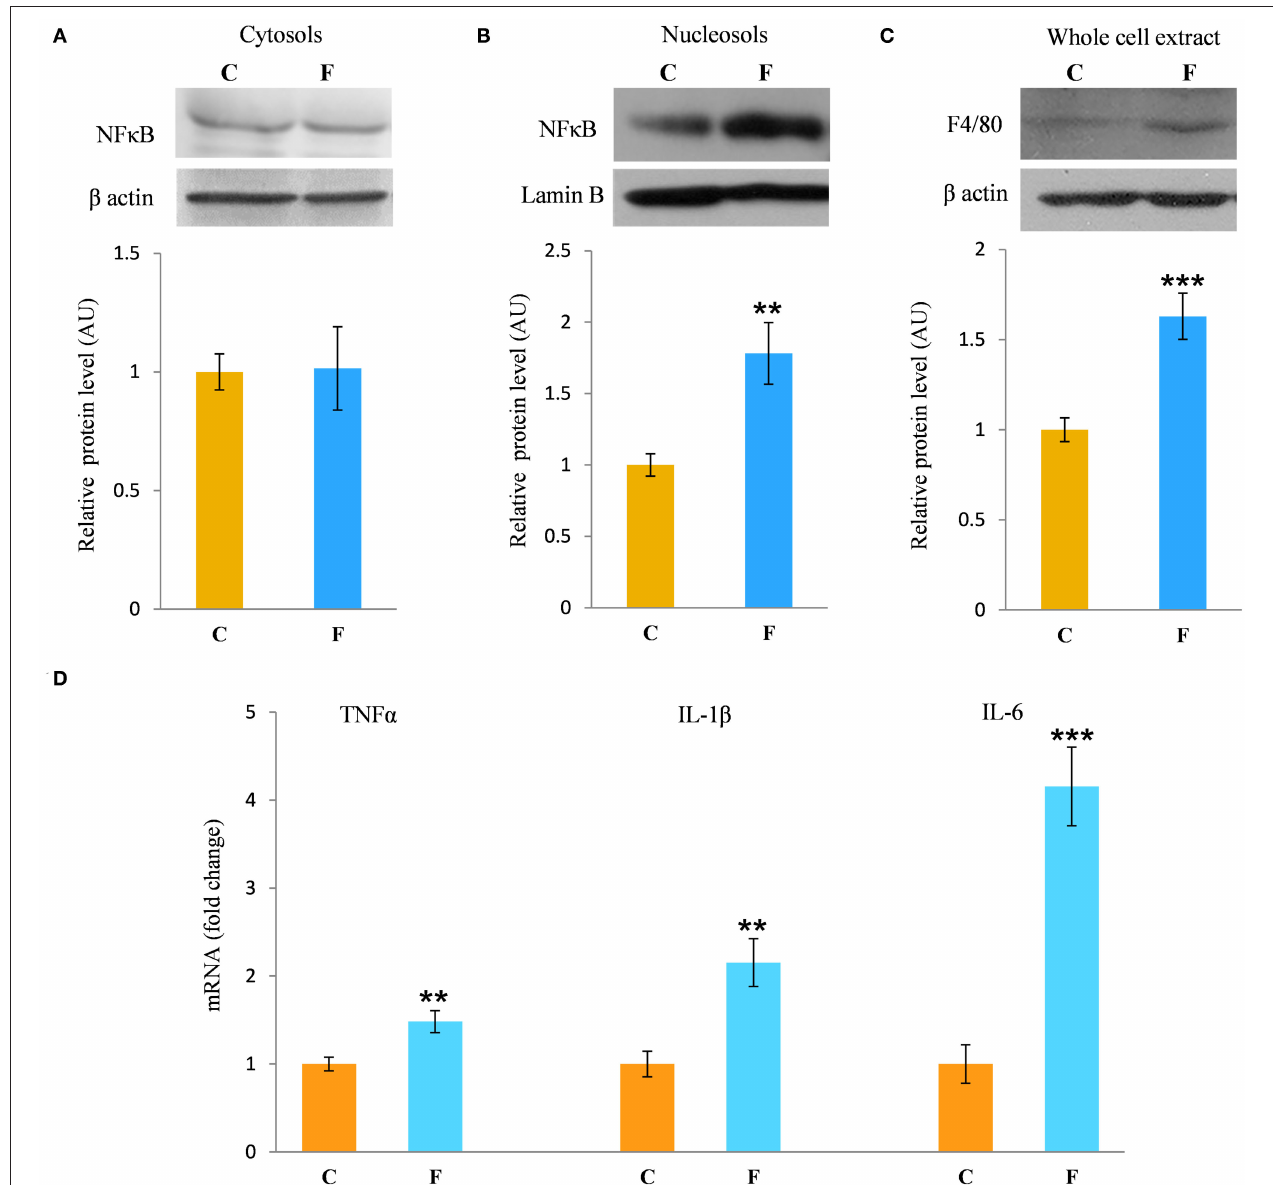
FIGURE 6 | Inflammation in the VAT of female rats fed with 10% fructose diet for 9 weeks. Protein level of NF κ B in (A) cytosols and (B) nucleosols, and protein level of (C) F4/80 in whole cell extracts were measured by Western blot in the VAT from control (C) and fructose-fed (F) rats, normalized to β actin and expressed in AUs. The values represent the means ± SEM. Statistical significance of the difference between experimental groups (Student’s t -test): ** P < 0.01 and *** P < 0.001, F vs. C. The level of TNF α , IL-1 β , and IL-6 mRNAs relative to HPRT mRNA were determined by TaqMan real-time PCR in the VAT (D) . The values represent the mean ± SEM ( n = 8 animals per group). All measurements were done in triplicate. Statistical significance of the difference between experimental groups (Student’s t -test): ** P < 0.01 and *** P < 0.001, F vs. C.